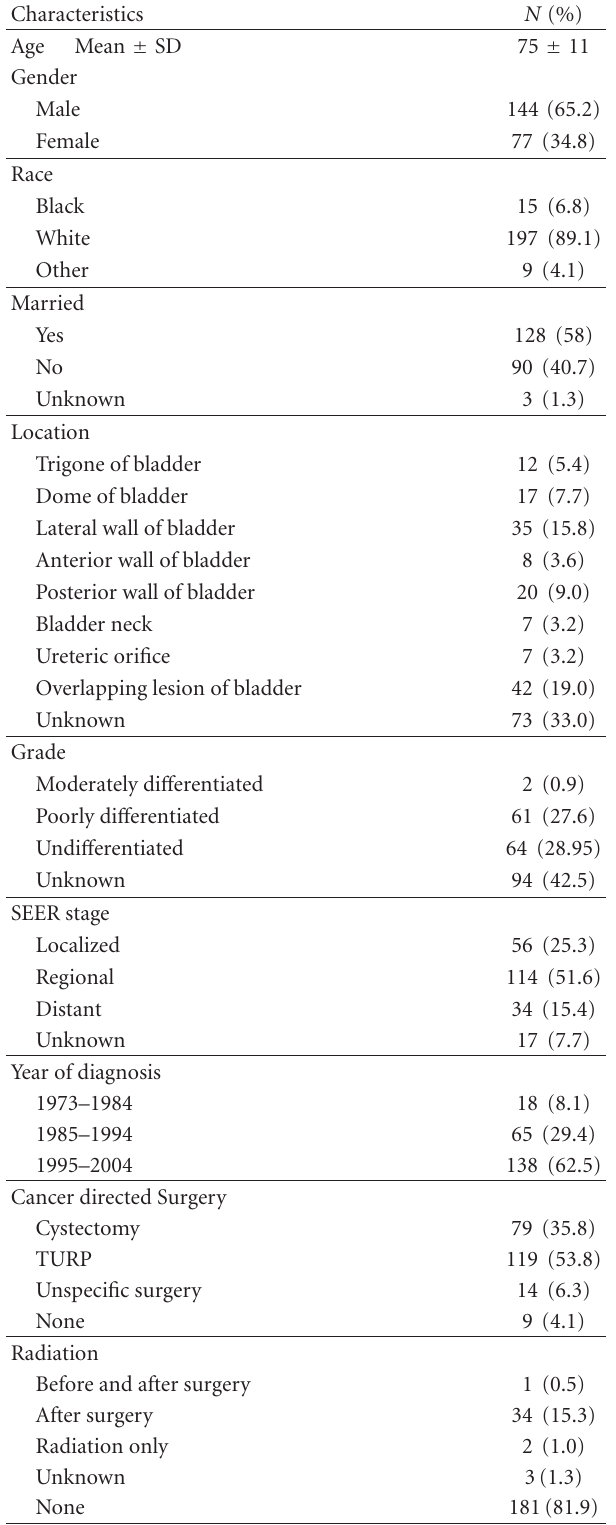
Table 2: Characteristics of 221 patients with sarcomatoid carci- noma (carcinosarcoma) of the urinary bladder diagnosed between January 1973 and December